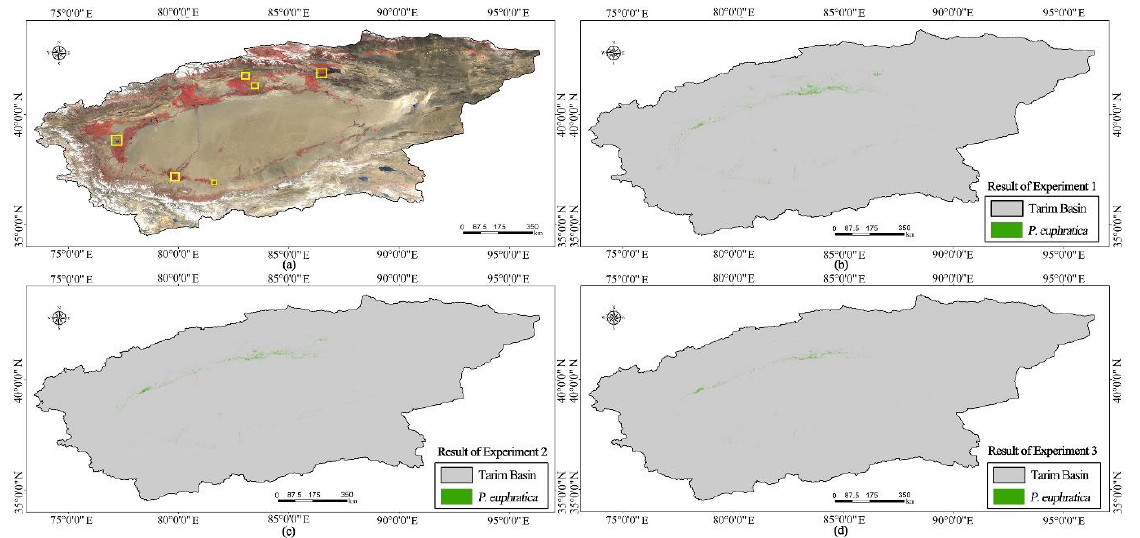
Figure 10. Results of experiment one, experiment two, and experiment three. ( a ) Sentinel-2 false color image of the study area, the yellow box represents the extra P. euphratica distribution obtained in experiment one and experiment two compared with experiment three; ( b ) results of experiment one; ( c ) results of experiment two; ( d ) results of experiment three.